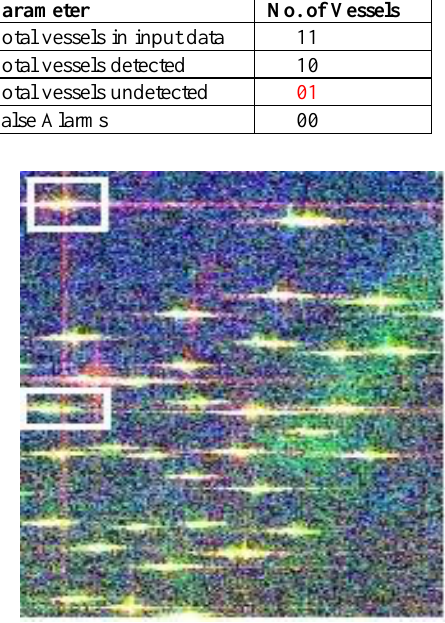
Fig. 5 ALOS PALSAR -1 sub-image B (size 209*165)